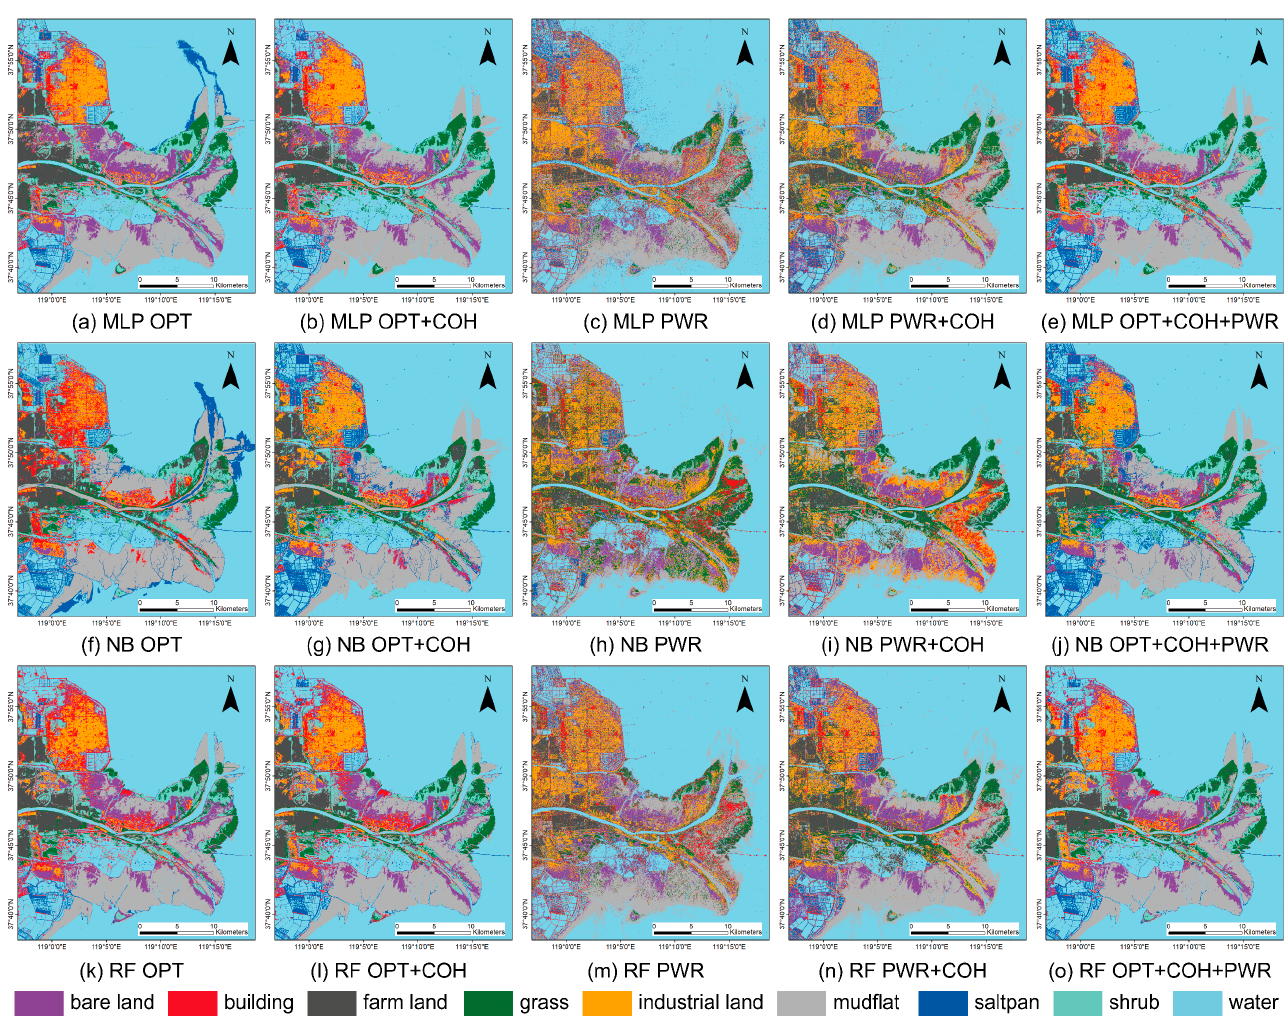
Figure 7. Classification results of MLP, NB, and RF methods derived from the OPT, OPT + COH, PWR, PWR + COH, and OPT + COH + PWR datasets.